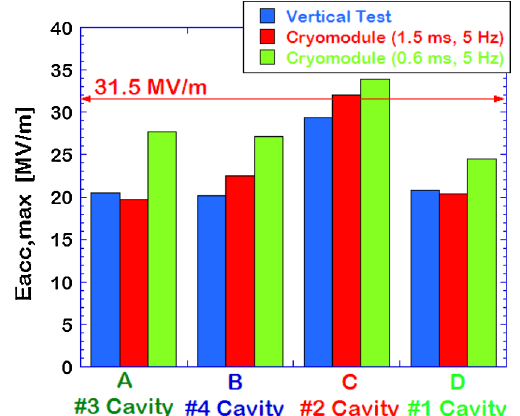
FIG. 19. (Color) Comparison between E cw tests and cryomodule tests in pulsed operation with 1 : 5 ms = 0 : 6 ms and 5